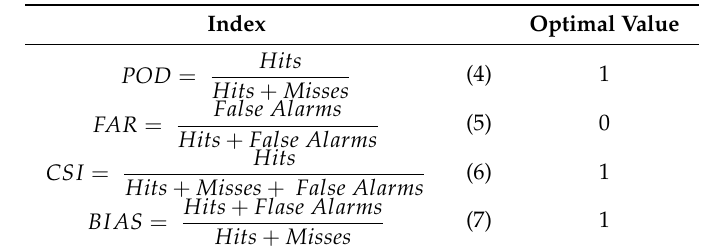
Table 4. The categorical indices used for the measurement of the performance of satellite precipitation products in detecting the occurrence of different intensities of rainfall events.